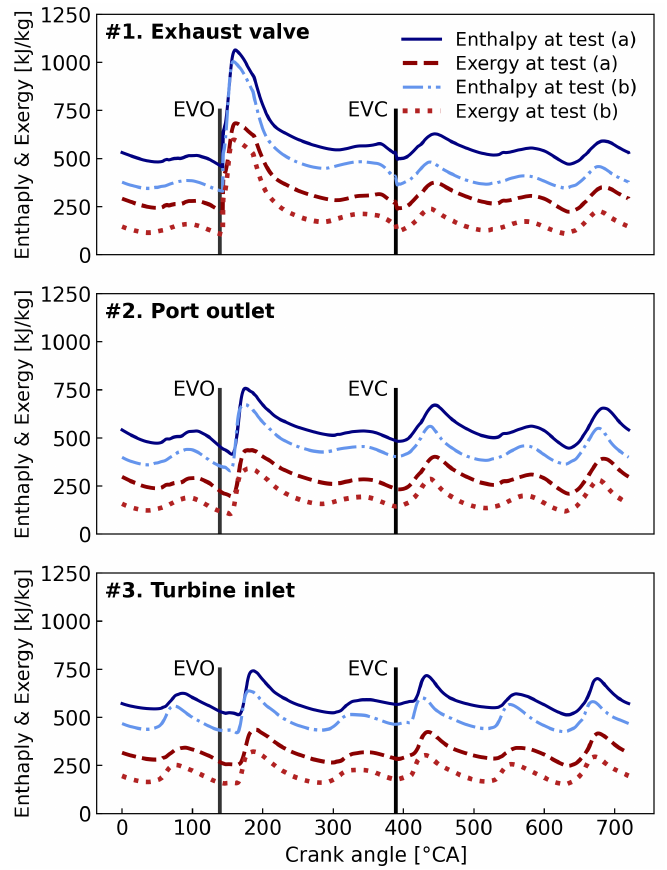
Figure 5. Specific enthalpy and exergy in exhaust pulsations at measurement positions operating at test points: (a) 1300 rpm/17.8 nIMEP; (b) 900 rpm/11.5